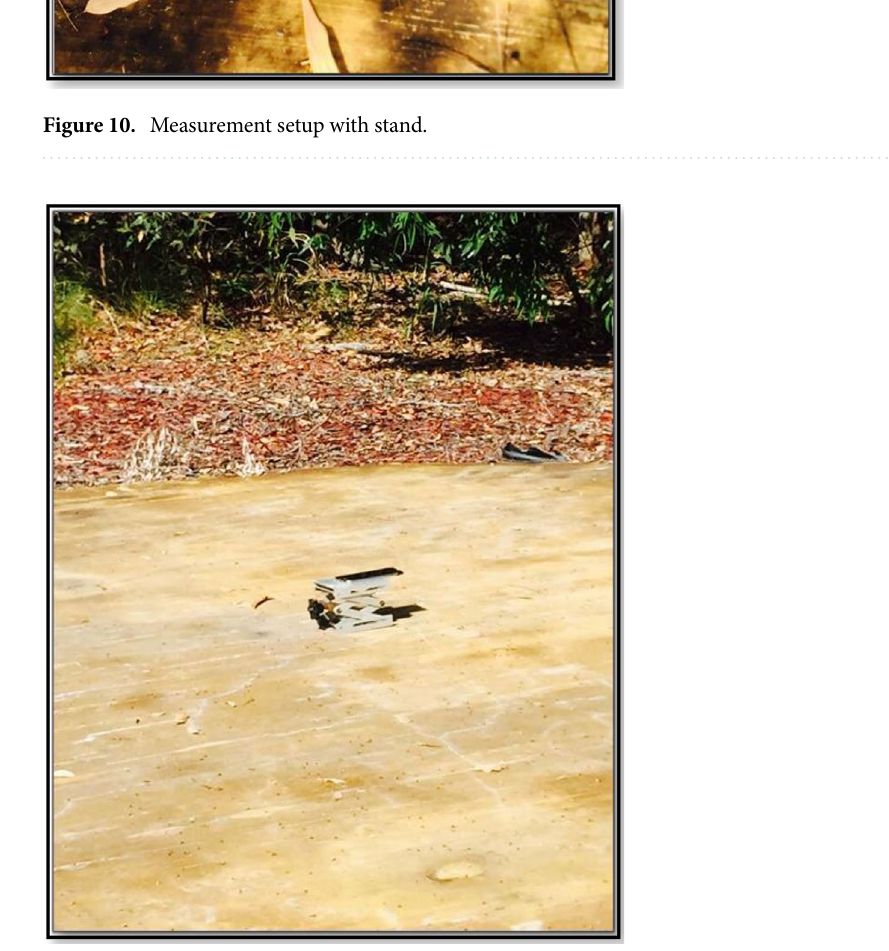
Figure 11. Measurement setup pointing directly at sunlight over Pad